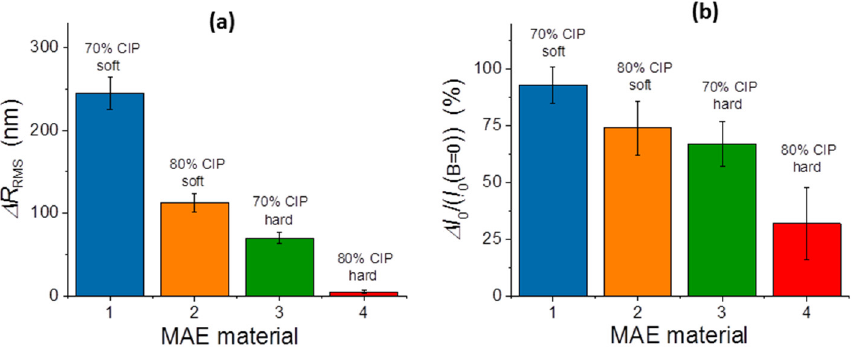
Figure 7. The modification of ( a ) the RMS surface roughness and ( b ) the relative modification of the reflected light intensity for different MAE materials.